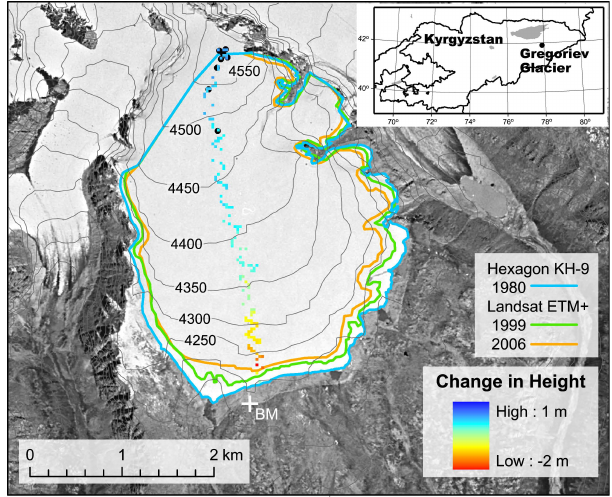
Fig. 1. Location (inset) and satellite image of the Gregoriev Glacier taken by Hexagon KH-9 on 21 August 1980 (Surazakov and Aizen, 2010). Glacier boundaries are manually delineated from satellite images of Hexagon KH-9 (1980) and pan-sharpened Landsat ETM+ (1999 and 2006). Contour lines (50-m interval) are drawn based on an SRTM-DEM (February 2000). The white cross and black dots denote the benchmark for GPS surveys and mass balance stakes, re- spectively. Coloured 15-m cells denote changes in elevation, which were averaged from 1-m resolution DEMs obtained by GPS surveys in July 2006 and August 2007 (see the text for